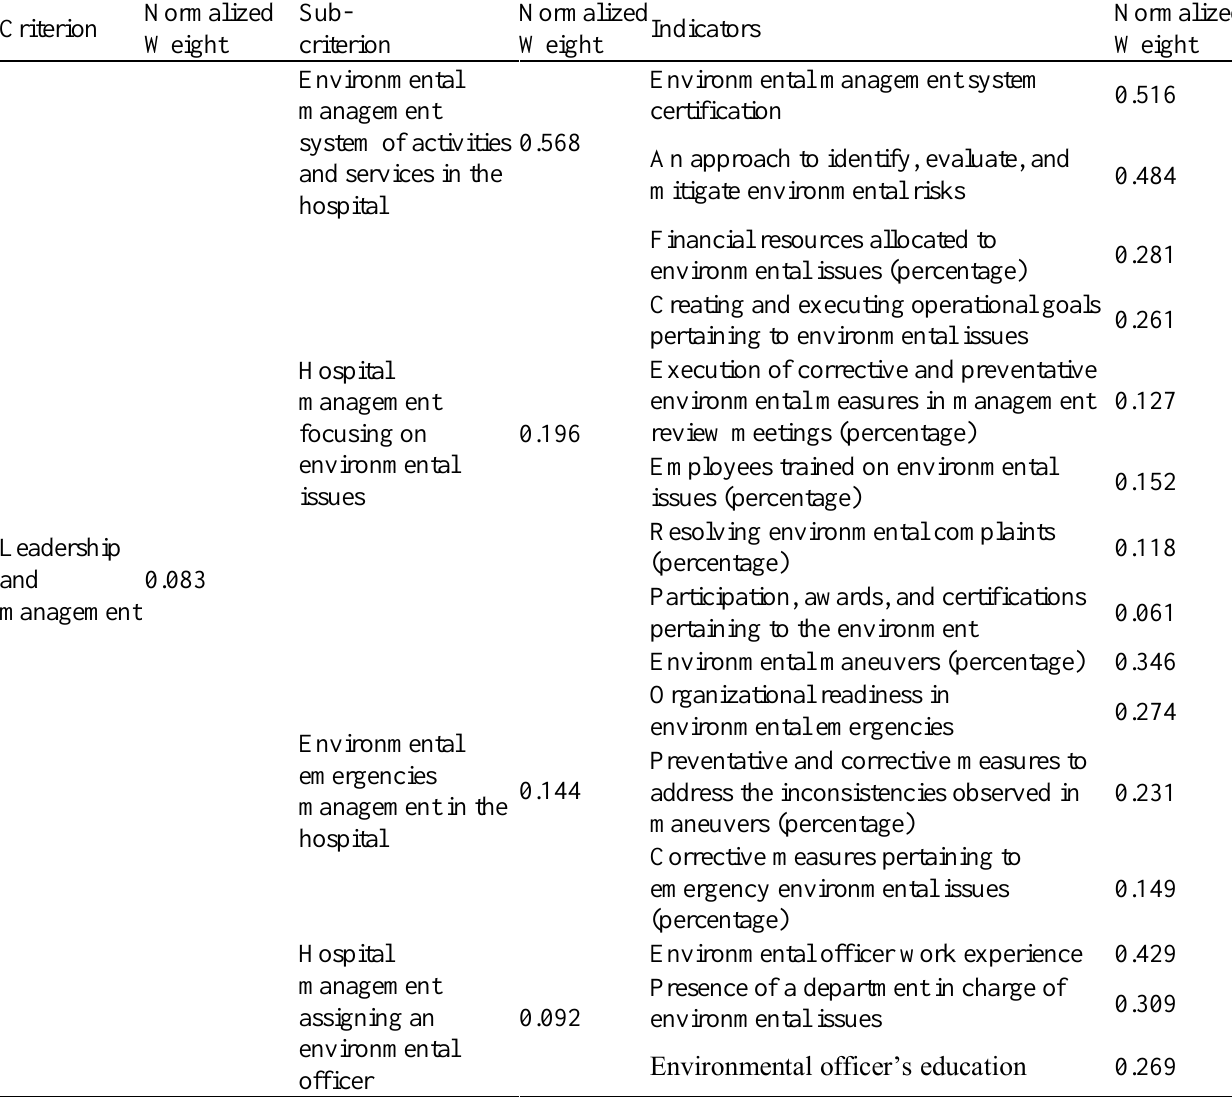
Table 6. Leadership and management sub-criteria, indicators and corresponding weights Criterion